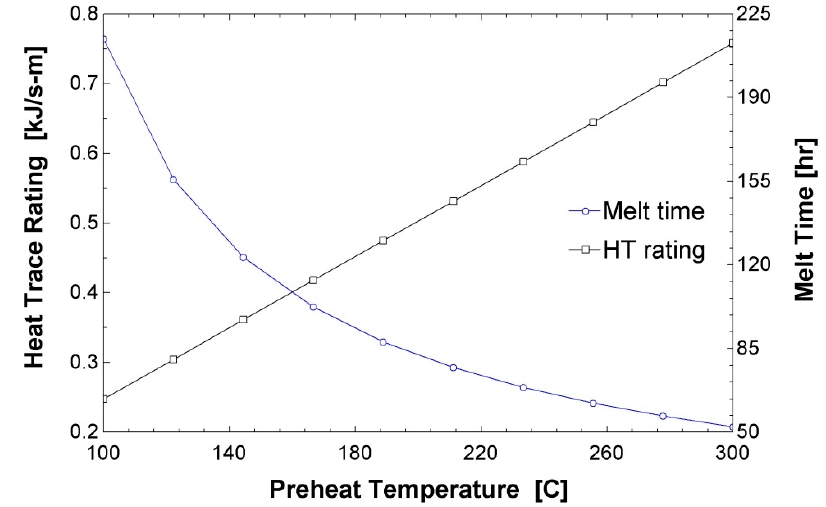
Figure 11. Effect of initial preheating temperature on melting time and the heat trace rating for a system with a 48” pipe using Solar Salt.